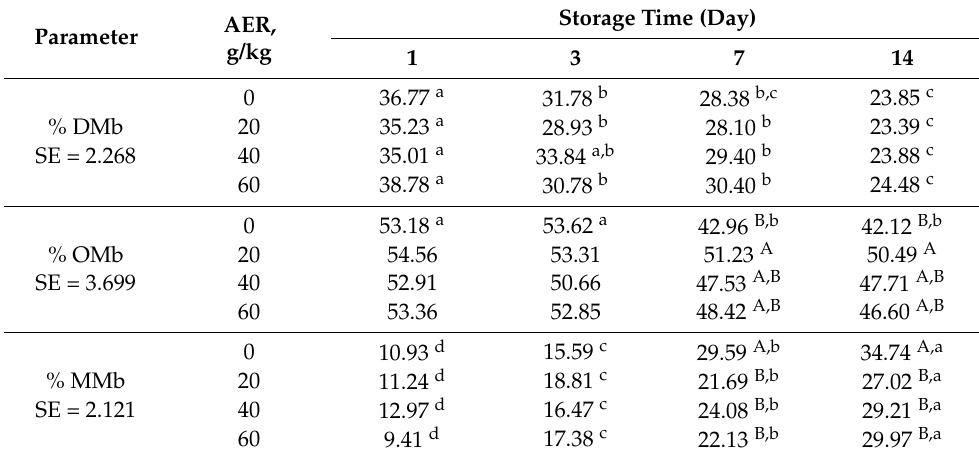
Table 3. Proportions of oxymyoglobin (OMb), deoxymyoglobin (DMb), and metmyoglobin (MMb) of LD from male dairy cattle with AER in TMR diets at different storage times. Parameter